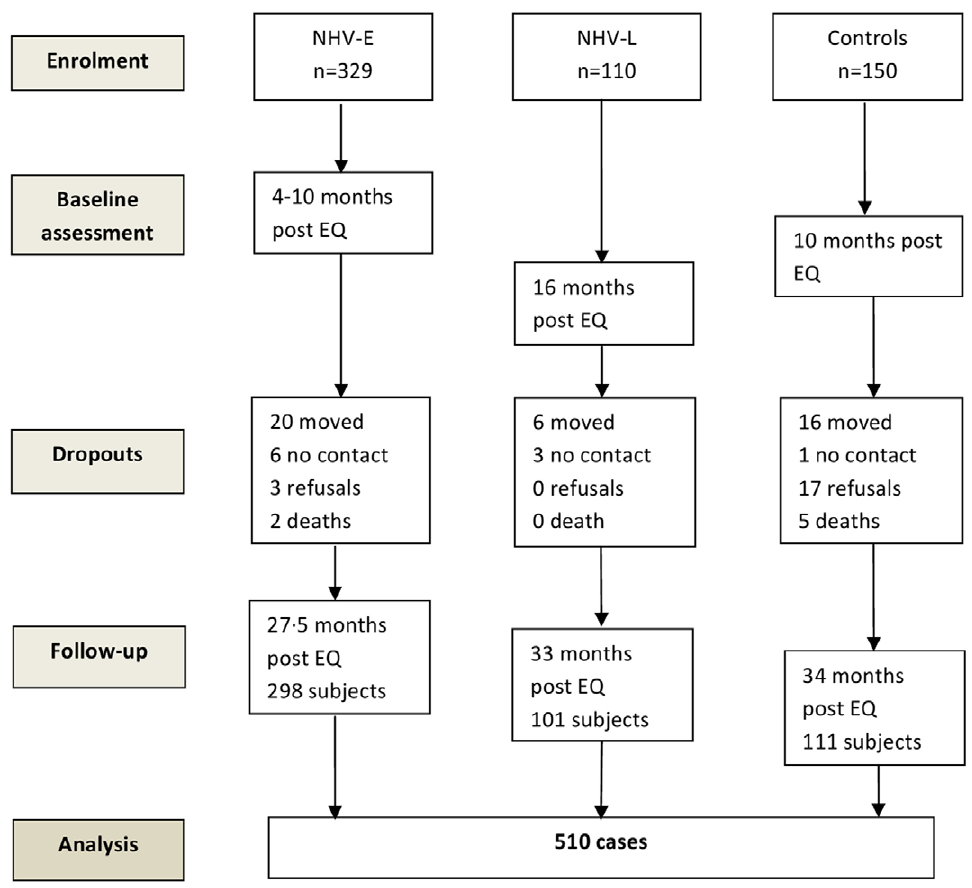
Figure 2. Subject flow in the NHV effectiveness study.